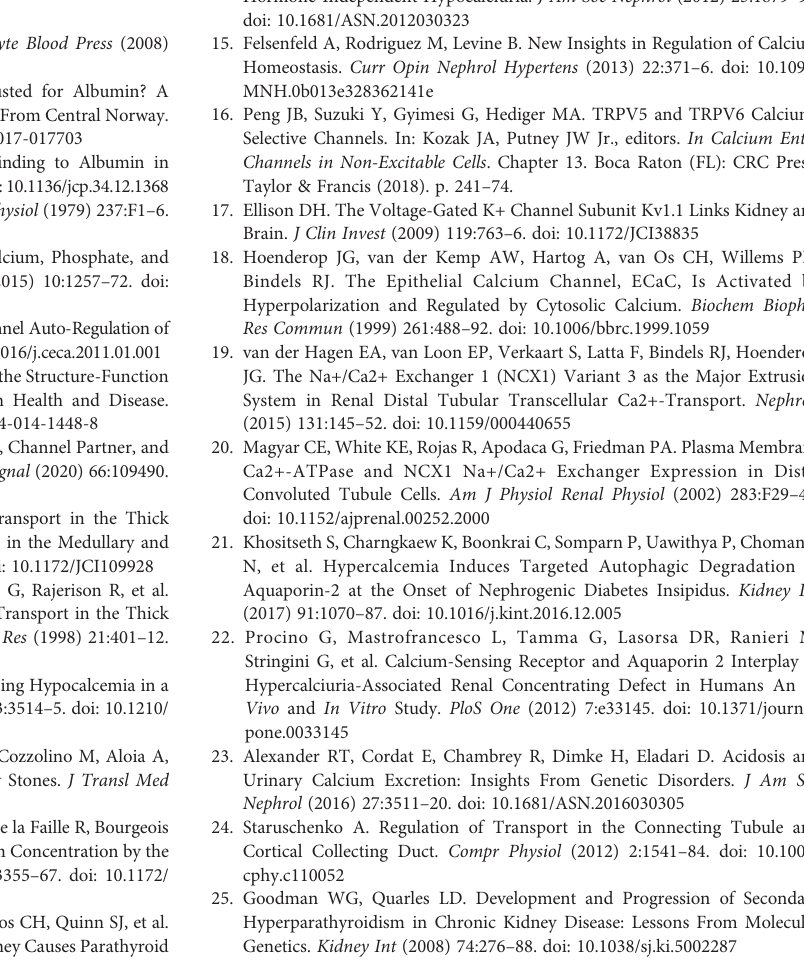
Supplemental Figure A | Nephron Phosphate Handling: CNI, calcineurin pathway; FGF23, fi broblast growth factor 23; FGF23R, fi broblast growth factor receptor; HPO 42- , H 2 PO 4- , organic phosphate anions; MAPK, map kinase; NHERF-1, Na + /H + exchanger regulatory factor 1; Na K ATPase, sodium potassium ATPase; NaPi2a, sodium phosphate cotransporter 2a; NaPi2c, sodium phosphate cotransporter 2c;PiT2,phosphate transporter; PKA/PKC, proteinkinaseA/C; PTH, parathyroid